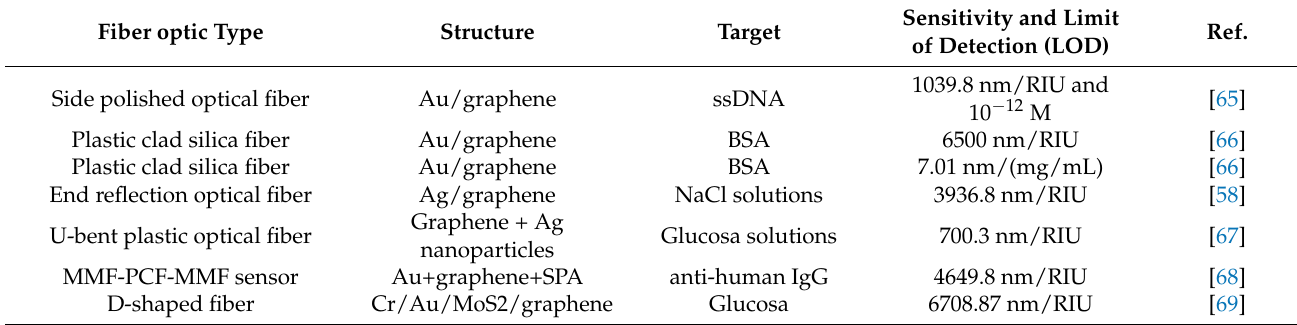
Table 3. A summary of selected papers regarding graphene-based optical fiber coupled SPR biosensor.